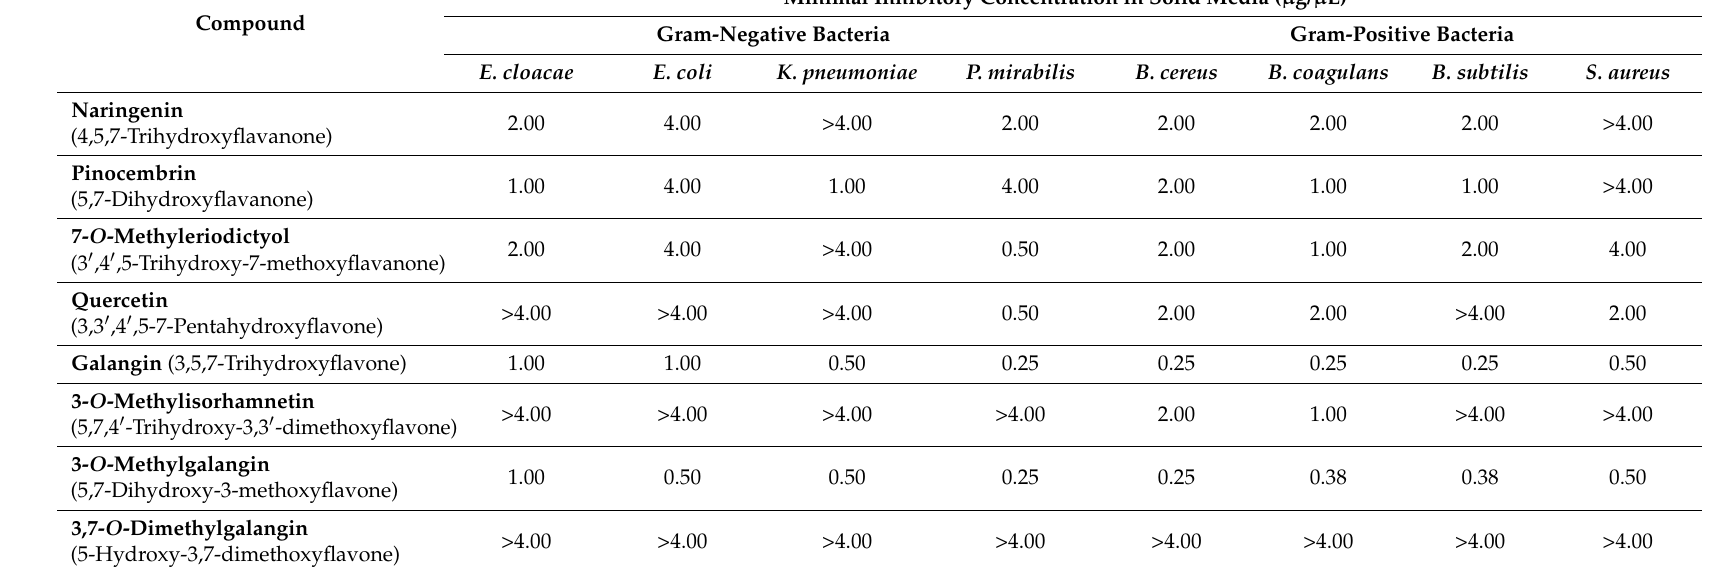
Table 1. Antibacterial activity of flavonoids in solid media against Gram-positive and Gram-negative